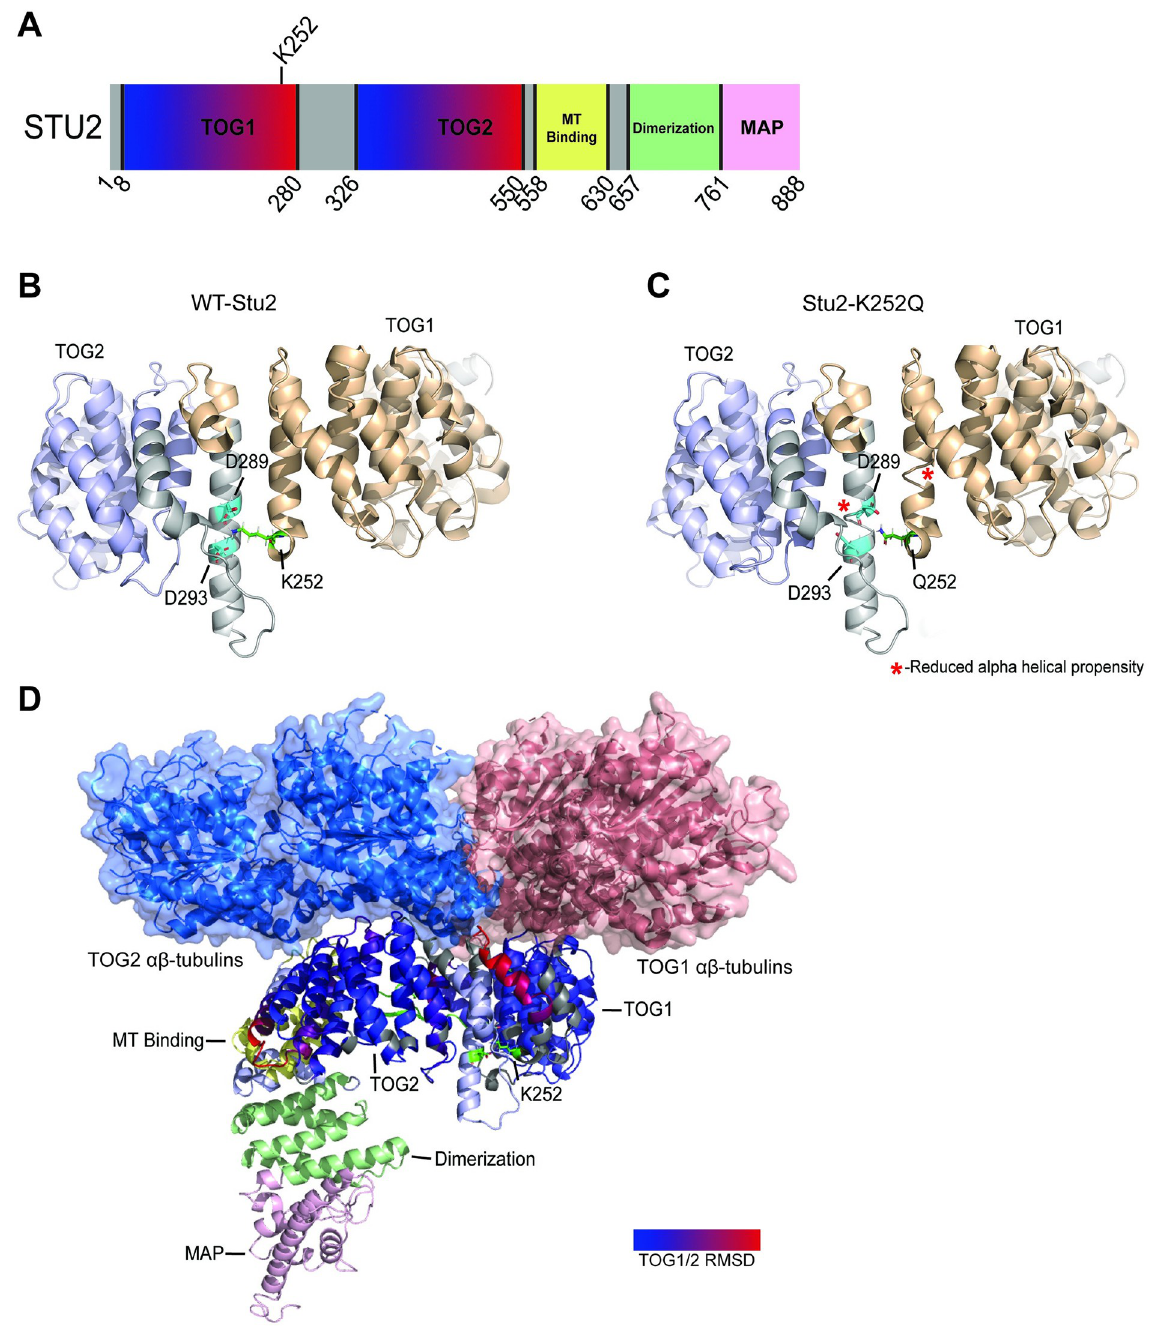
Fig 14. Modeling predicts that acetylation at Stu2 K252 may regulate intra-helical salt bridges between TOG1 and TOG2 domains. (A) Lysine 252 lies at the c-terminal end of TOG1. I-TASSER modeling of WT-Stu2 (B) and Stu2-K252Q (C) indicate that K252 forms salt bridges with D289 and D293 on an adjacent α -helix. This model predicts that these salt bridges confer stability to the intra-TOG domain linker region. We note that mapping the TOG1 section of the TOG1/ αβ -tubulin crystal structure (pdb:4FFB) and the TOG2 section of the TOG2/ αβ -tubulin crystal structure (pdb:4U3J) structure to our I-TASSER model resulted in a steric clash between the two coordinated tubulin heterodimers (D). This suggests that the I-TASSER model positions the two TOG domains too closely. Alternatively, we speculate that acetylation of K252 may increase the distance between the TOG domains. The two αβ -tubulin heterodimers are shown in blue and pink respectively.